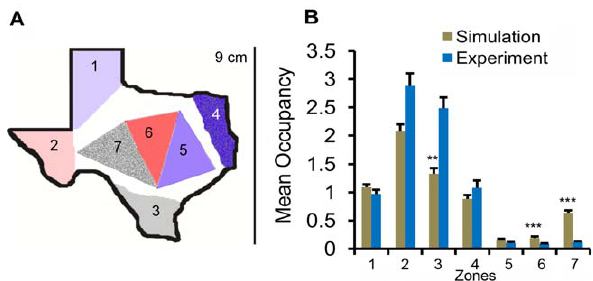
Figure 8. Positional preferences from experiments and simu- lations in Texas arena. We examined the preference of seven spatial zones inside the arena: four corners (zones 1, 2, 3, and 4) and three internal regions (zones 5, 6, and 7). Zone 5 is a triangle connecting three cities: Dallas, San Antonio and Houston. Zone 6 connects Dallas, San Antonio and Abeline, while zone 7 connects San Antonio, Abeline and Fort Stockon. The simulations captured several trends similarly to the experiments, but underemphasized the responses to the preferred areas and overemphasized the less preferred - especially zone 7. The asterix indicates significant difference between simulations and experiments (*: p v 0 : 05 , **: p v 0 : 001 , and ***: p v 0 : 0001 ).